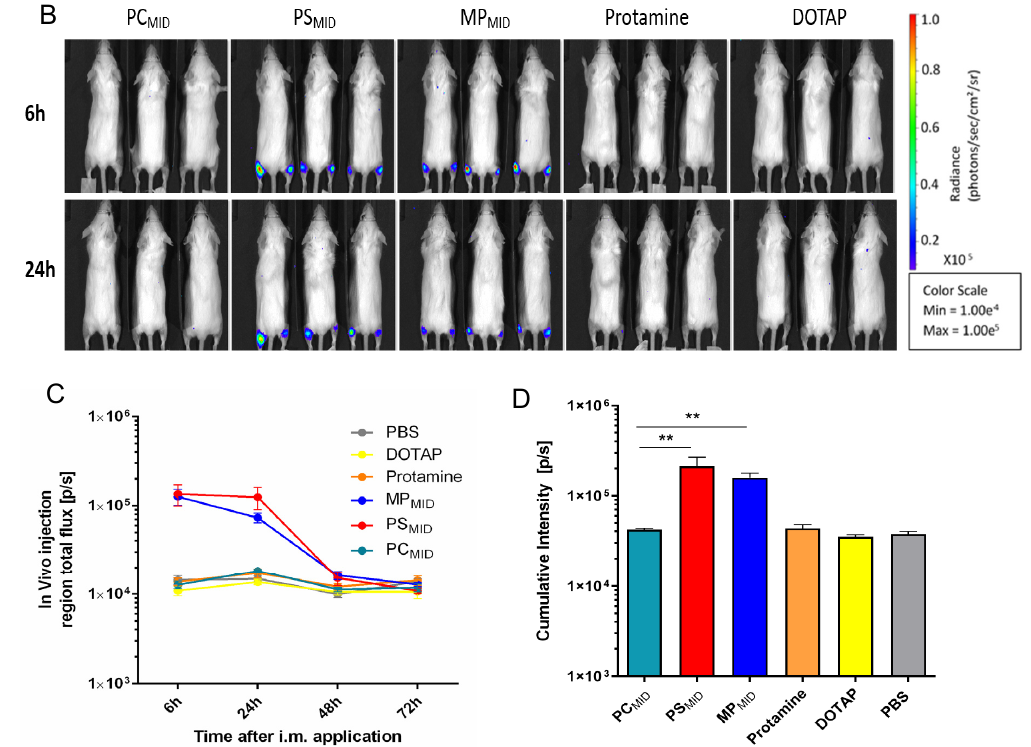
Figure 5. ( A ) HEK293 cell transfection of di ff erent protamine / DOTAP hybrid nanoparticles at di ff erent compositions in comparison to protamine / mRNA and DOTAP / mRNA particles. *** p < 0.001. Statistical significance was determined using two-way ANOVA combined with a Bonferroni comparison